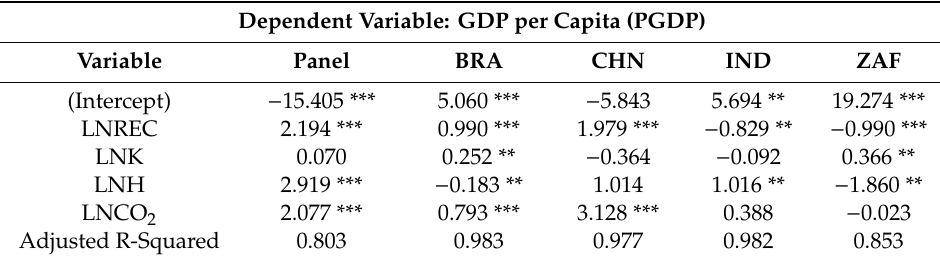
Table 7. Estimation results of the renewable energy and CO 2 emissions on GDP